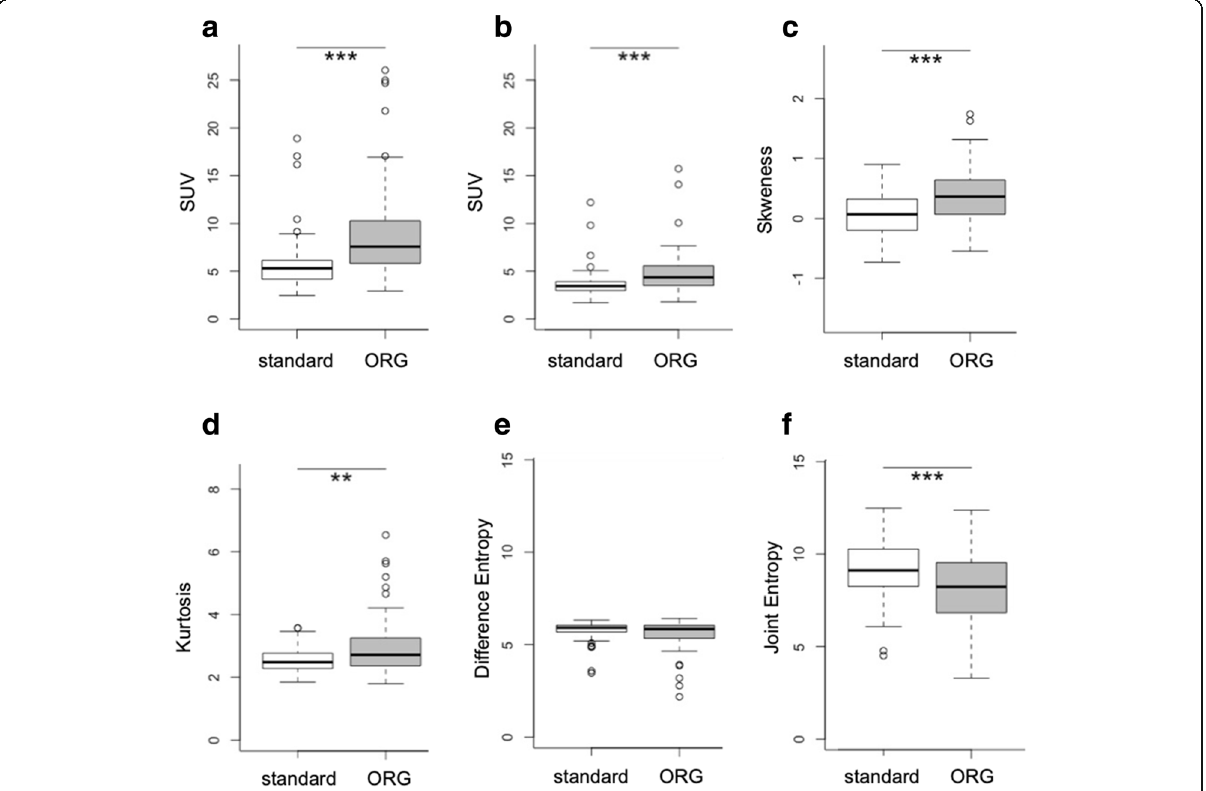
Fig. 3 Optimal respiratory gating impacts the quantification of [ 18 F]FDG PET-derived image parameters. The quantification of PET-derived parameters changes significantly after compensating for respiratory motion, as demonstrated for a SUV max , b SUV mean , c skewness, d Kurtosis, e difference entropy, and f joint